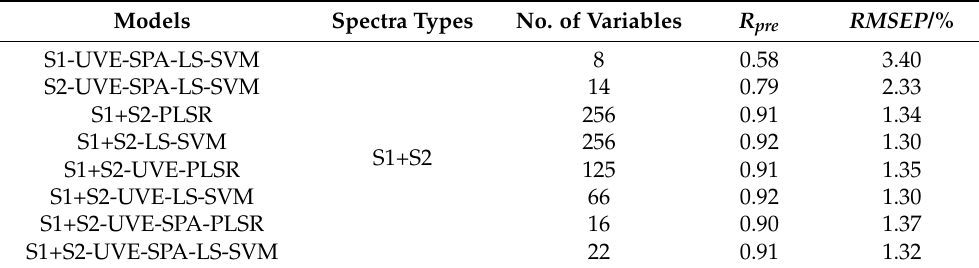
Table 4. Comparison of different models for building a general model. Models Spectra